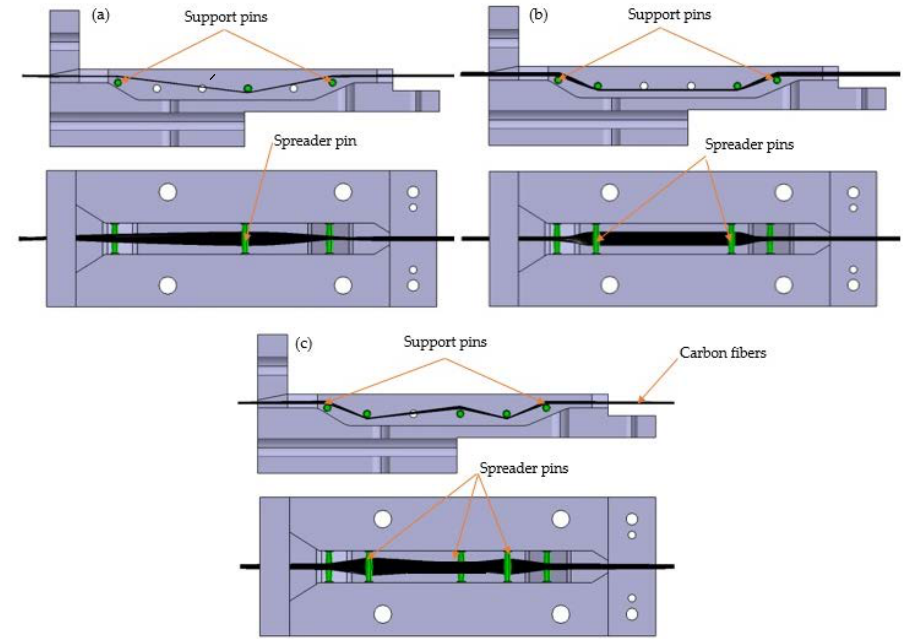
Figure 2. Various impregnation dies designs used in this study: ( a ) Pin layout 1—one spreader pin, ( b ) Pin layout 2—two spreader pins, and ( c ) Pin layout 3—three spreader pins.